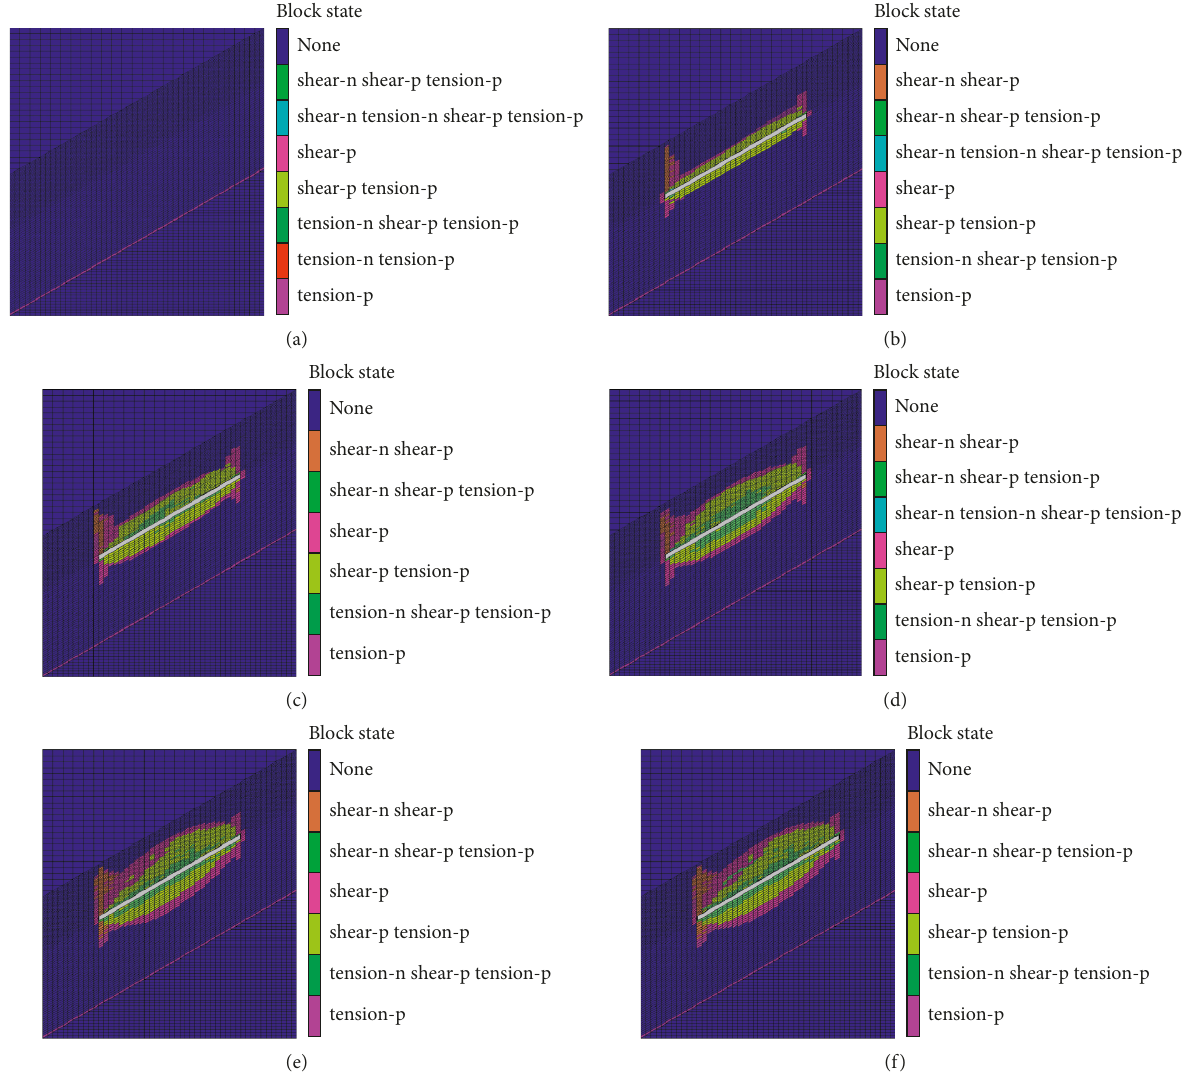
Figure 4: Plastic failure zone of workface floor along the inclined direction of the coal seam with the advancement of the workface. (a) Before workface mining. (b) Advanced 20 m of workface. (c) Advanced 40m of workface. (d) Advanced 60m of workface. (e) Advanced 80m of workface. (f) Advanced 100 m of workface.